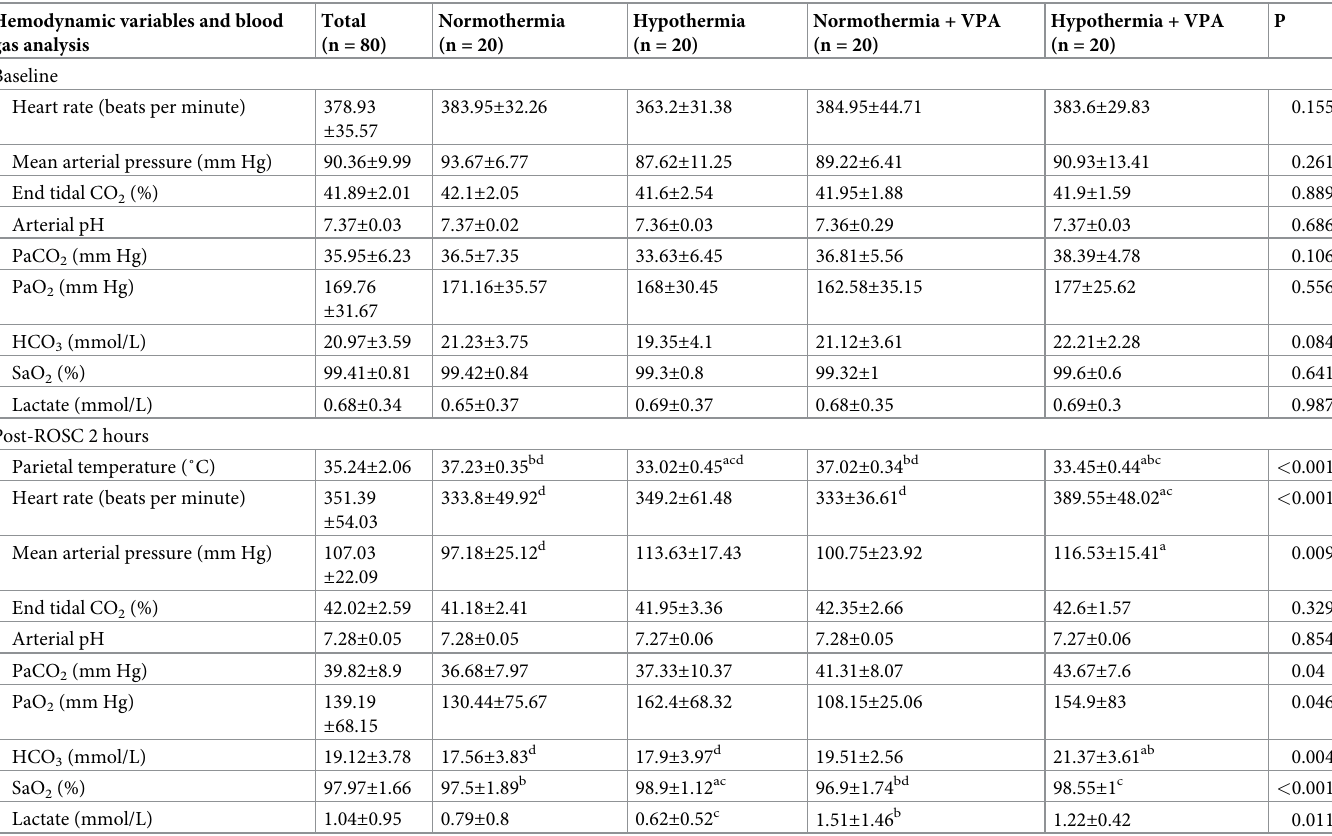
Table 2. Hemodynamic variables blood gas analysis of baseline and 2 hours after return of spontaneous circulation. Hemodynamic variables and blood gas